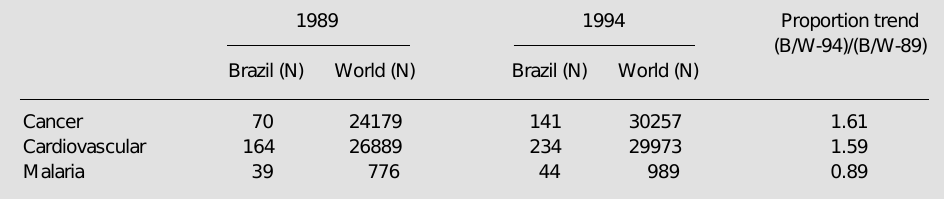
Table 2 - Brazil’s share of world publications in cancer, cardiovascular and malaria research. Relative proportion trends indicate the progress of Brazilian output in each area compared to the world progress during the period from 1989 to 1994. B/W-94 and B/W-89 indicate the number of Brazilian articles divided by the number of world articles for each area. Data taken from Ref.